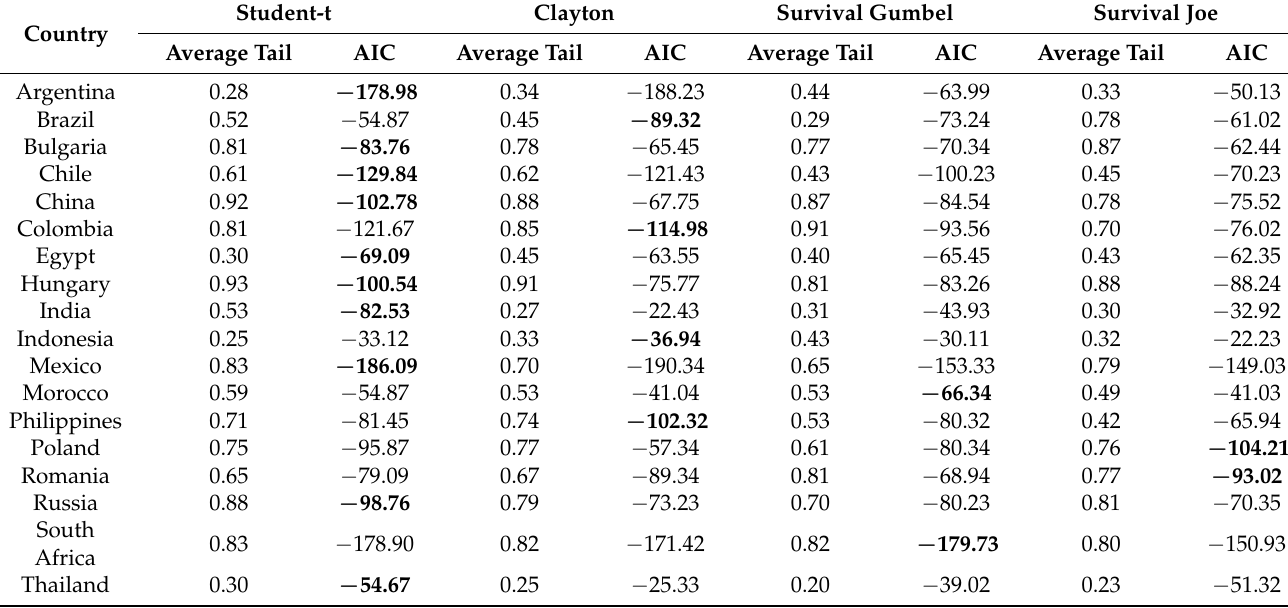
Table 6. Model comparison and average time-varying tail